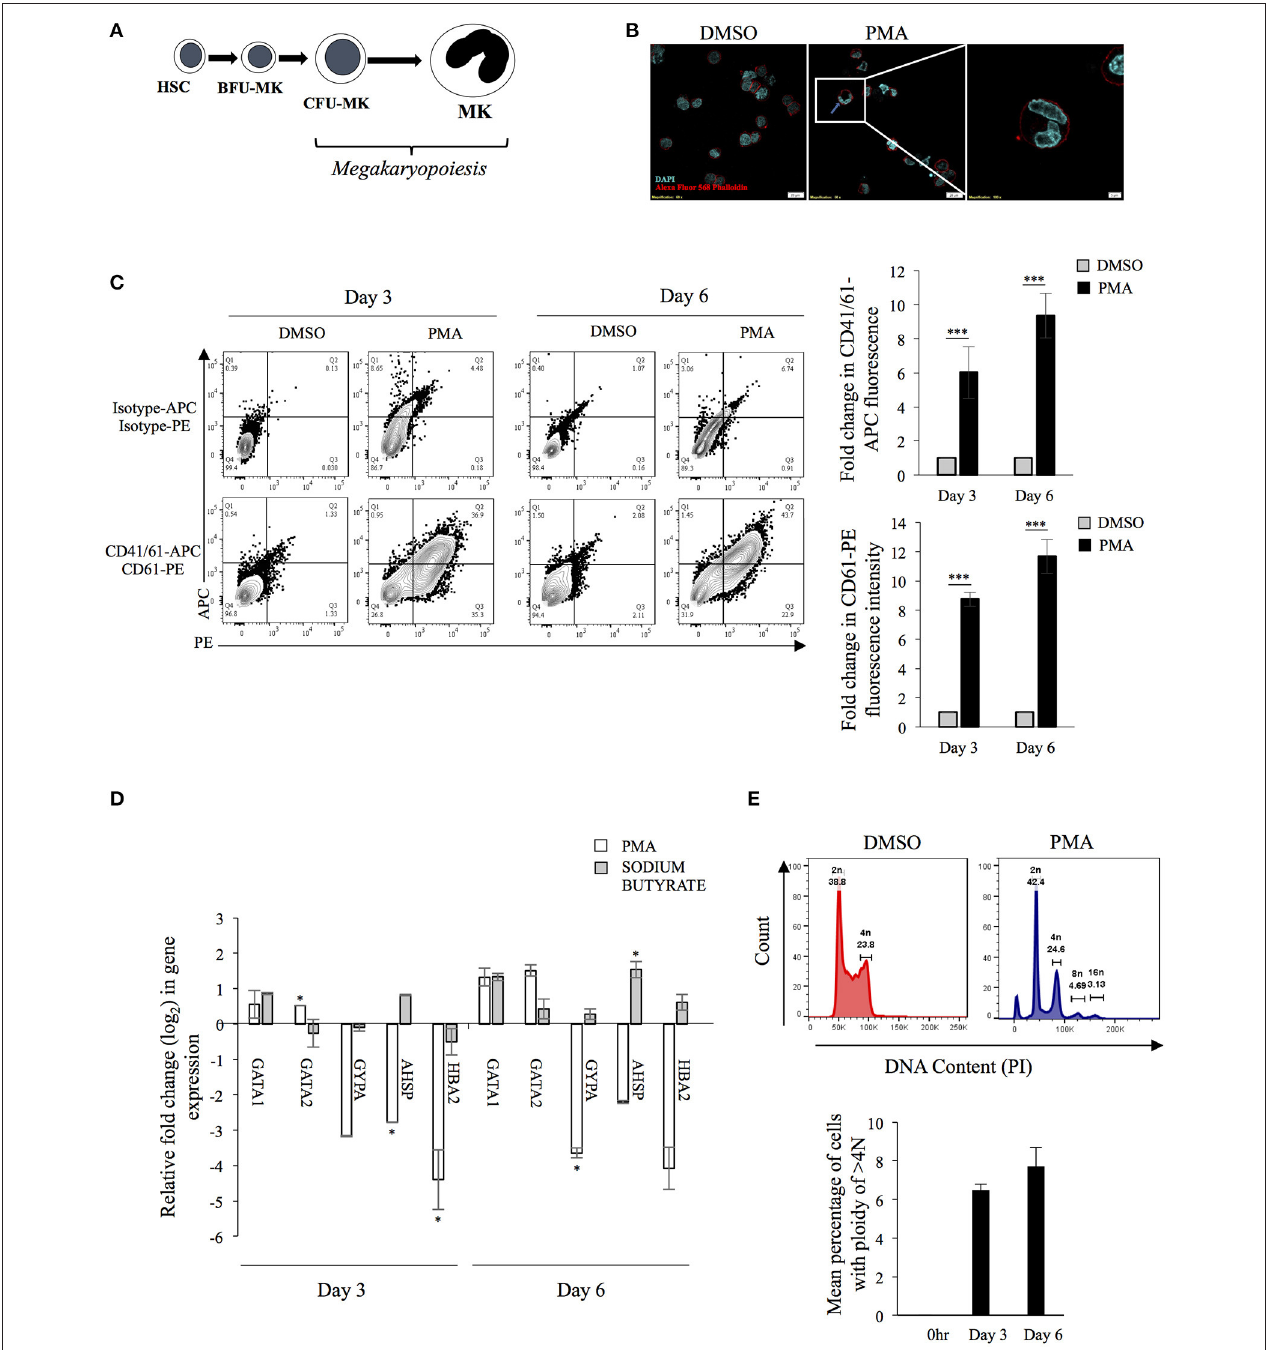
FIGURE 1 | (A) Schematic diagram of megakaryopoiesis: The schematic diagram represents select stages during the differentiation of Hematopoietic stem cells (HSC) to Megakaryocytes (MKs) through Blast-forming unit-Mk (BFU-MK) and Colony-forming unit-Mk (CFU-MK). Cell enlargement and formation of multilobed nucleus has been depicted. (B) Formation of multi-lobed nucleus following PMA induced differentiation of K562 cells. K562 cells treated with either DMSO or 50nM PMA for 6 days were stained with Alexa Fluor-568 Phalloidin and DAPI and visualized in a confocal microscope. The red color indicates the plasma membrane and blue color shows nuclei. The inset shows a cell with multilobed nucleus. (C) Expression of platelet specific surface markers: K562 cells treated with PMA for 0, 3, or 6 days were immune-stained for expression of the indicated surface marker protein using fluor-conjugated primary antibodies. The mean fluorescence intensity (MFI) corresponding to each day was quantified. For each surface marker the MFI at day 0 was arbitrarily set to 1 and those at day 3 and 6, expressed as the relative fold change with respect to that. (D) Total RNA from K562 cells treated with either DMSO or 50nM PMA or 1mM sodium butyrate for 3 or 6 days was extracted and purified. The RNA was reverse transcribed with random hexamers and the cDNA used for real-time PCR estimation of mRNA transcripts from indicated genes. The C T